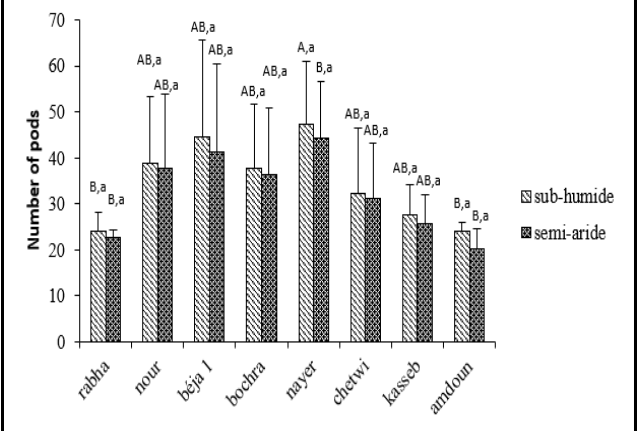
Figure 4: Mean values of the pods number as a function of the